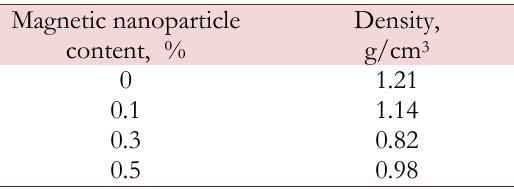
The obtained values for the density of the magnetic composites are presented in Tab. 3.